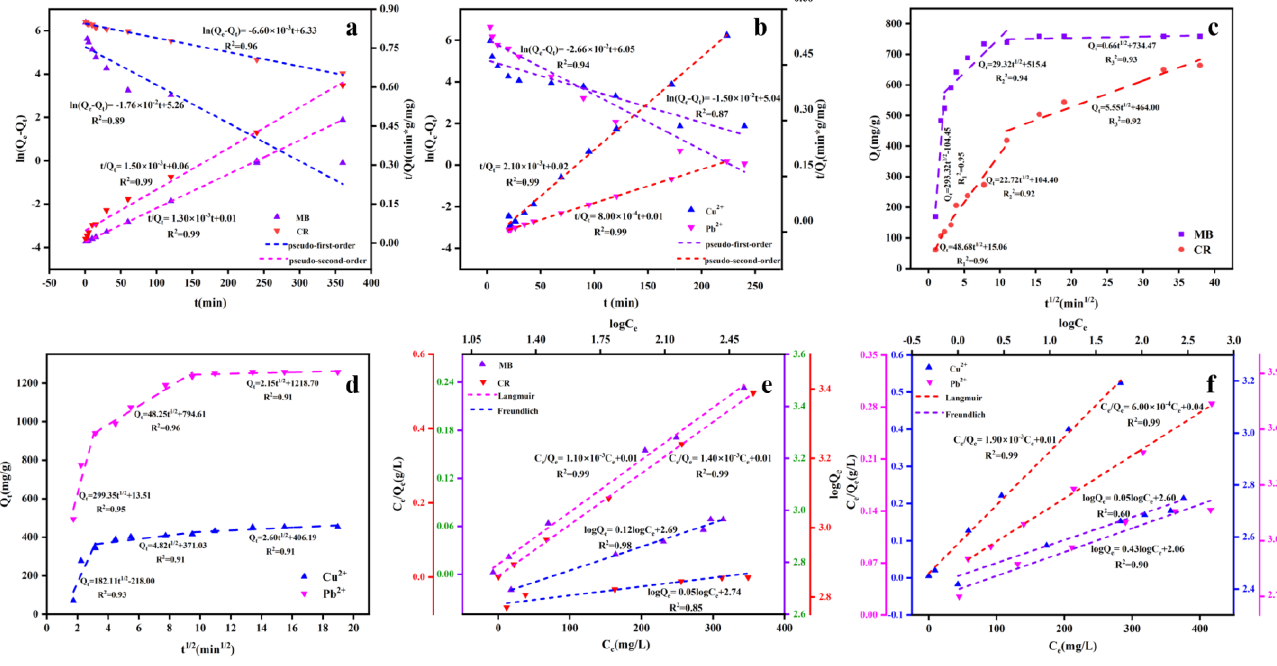
Figure 3. The linear plot of pseudo − first − order and pseudo − second − order adsorption kinetics by UBC: MB and CR ( a ), Cu 2+ and Pb 2+ ( b ). The intraparticle diffusion model: MB and CR ( c ), Cu 2+ and Pb 2+ ( d ); the adsorption isotherm of Langmuir and Freundlich by UBC: MB and CR ( e ), Cu 2+ and Pb 2+ ( f ).